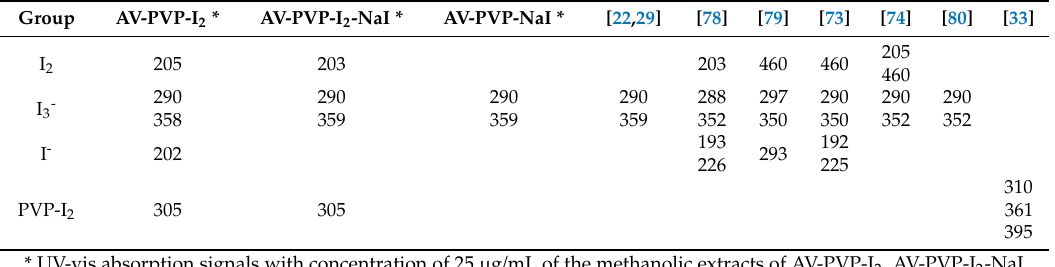
Table 3. UV-vis absorption signals of iodine moieties in the samples AV-PVP-I 2 , AV-PVP-I 2 -NaI and AV-PVP-NaI in previous reports (nm).